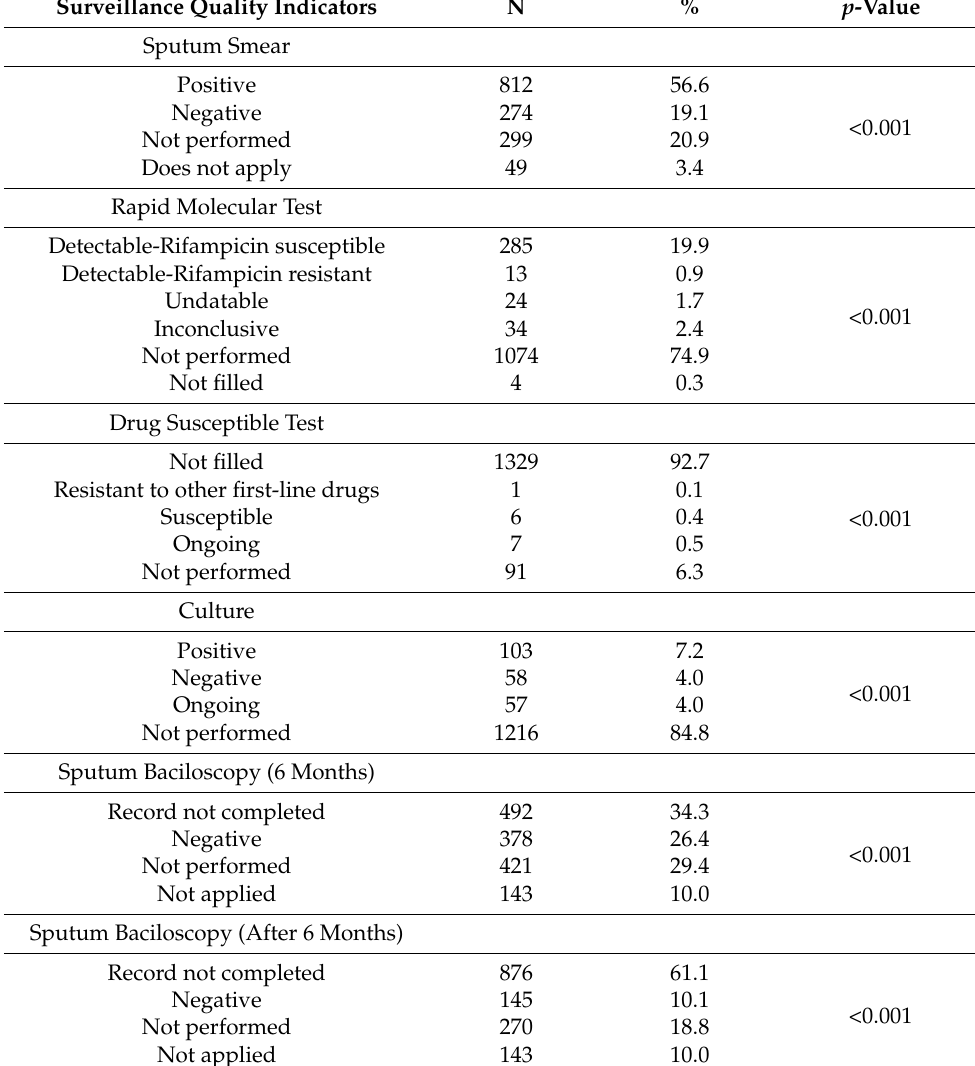
Table 2. Surveillance quality indicators. Tuberculosis cases in Ananindeua, Par á from 2018 to